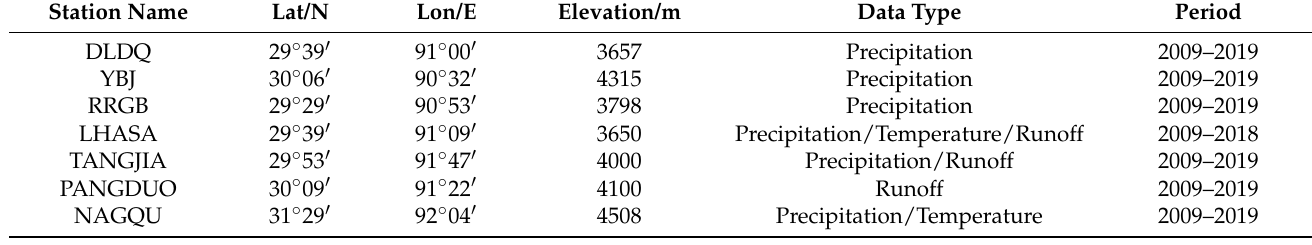
Table 1. Information on meteorological and hydrological stations.